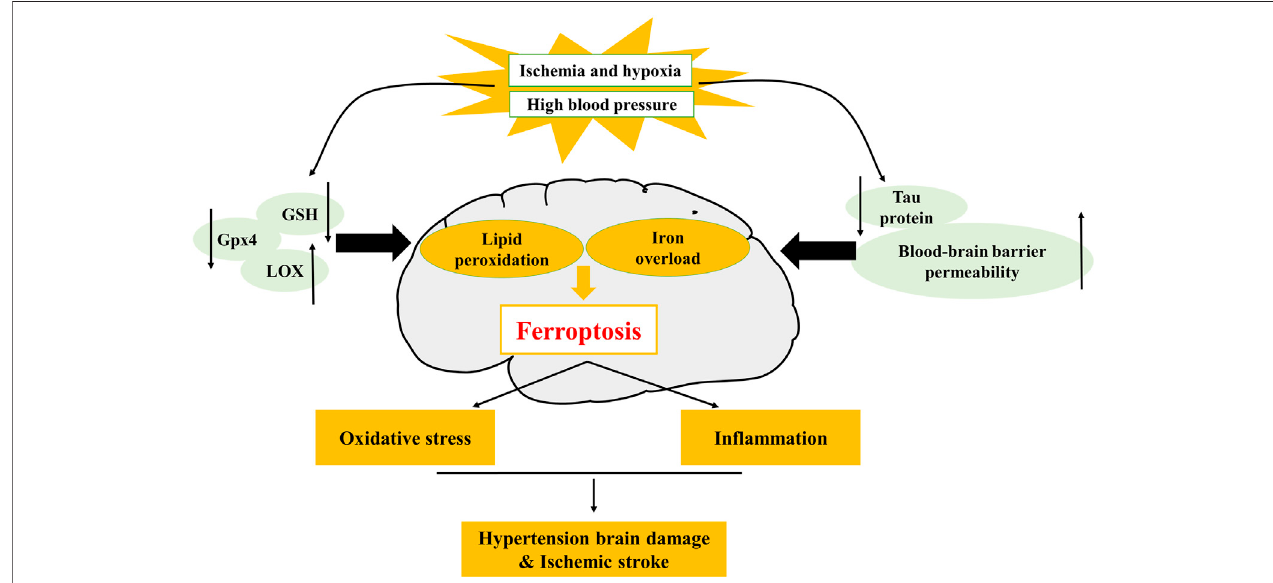
FIGURE 2 | Mechanism of ferroptosis in hypertension and ischemic stroke. The decrease of glutathione peroxidase 4 (GPX4), glutathione (GSH), tau protein, and the increase of lipoxygenase (LOX), blood-brain barrier (BBB) permeability, can lead to the occurrence of ferroptosis. LOX is involved in hypertensive brain injury, tau protein and BBB permeability are involved in ischemic